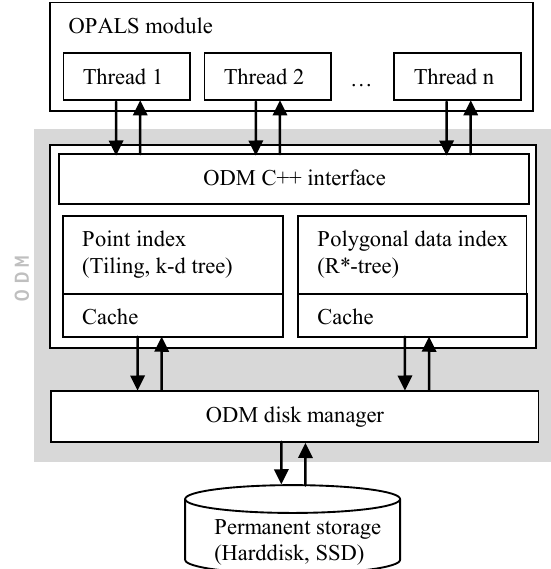
Figure 6. Internal structure of the